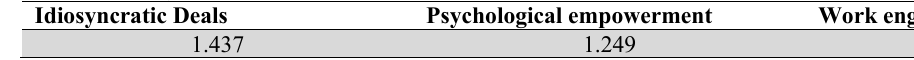
Full Collinearity test Idiosyncratic Deals